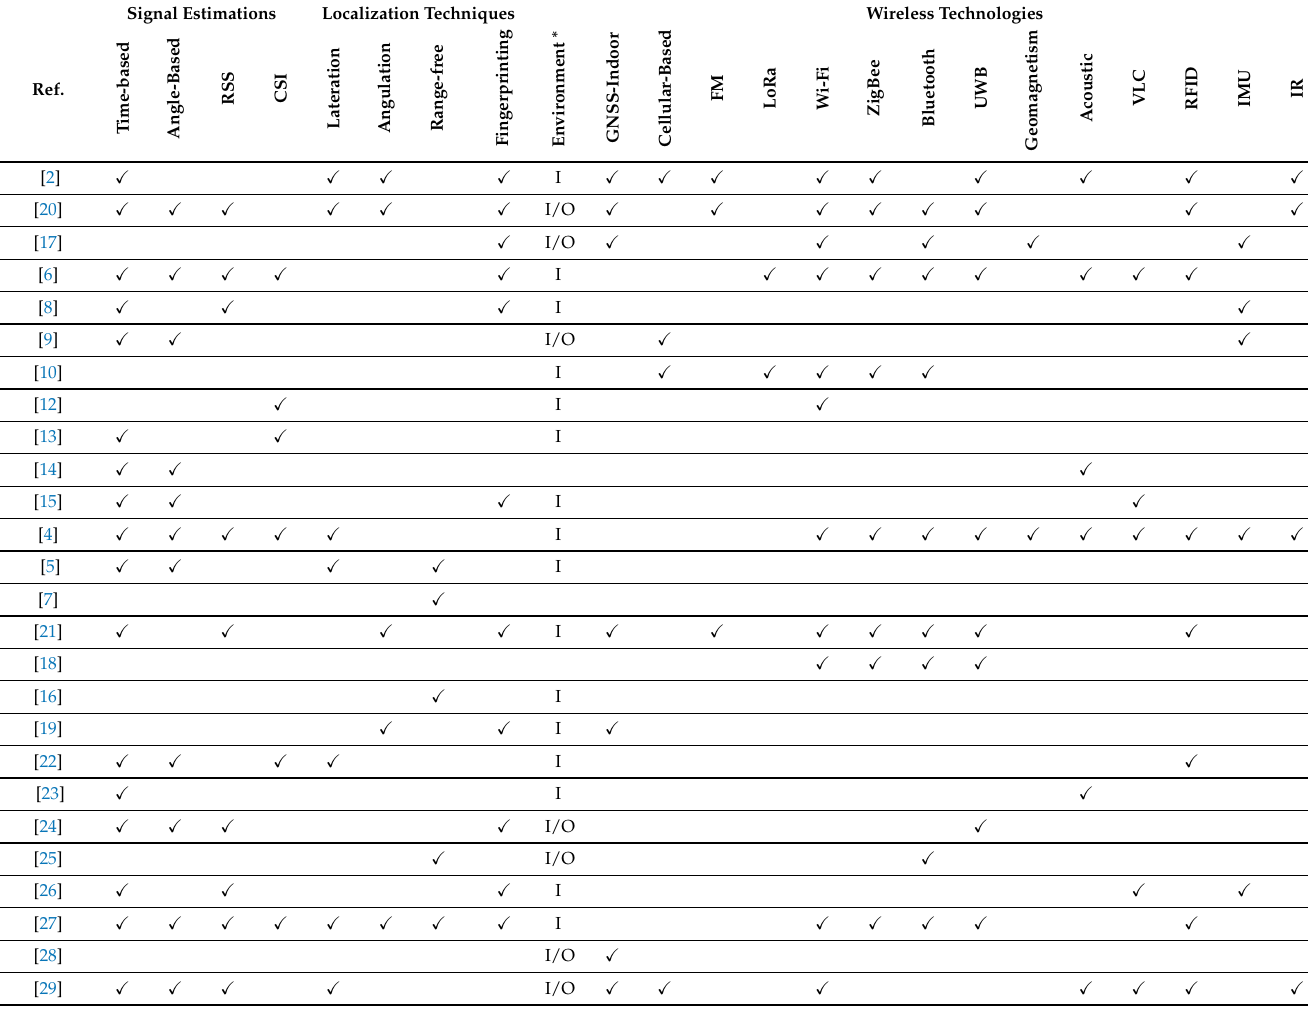
Table 1. Comparative analysis for surveys/review papers on wireless positioning systems from the existing